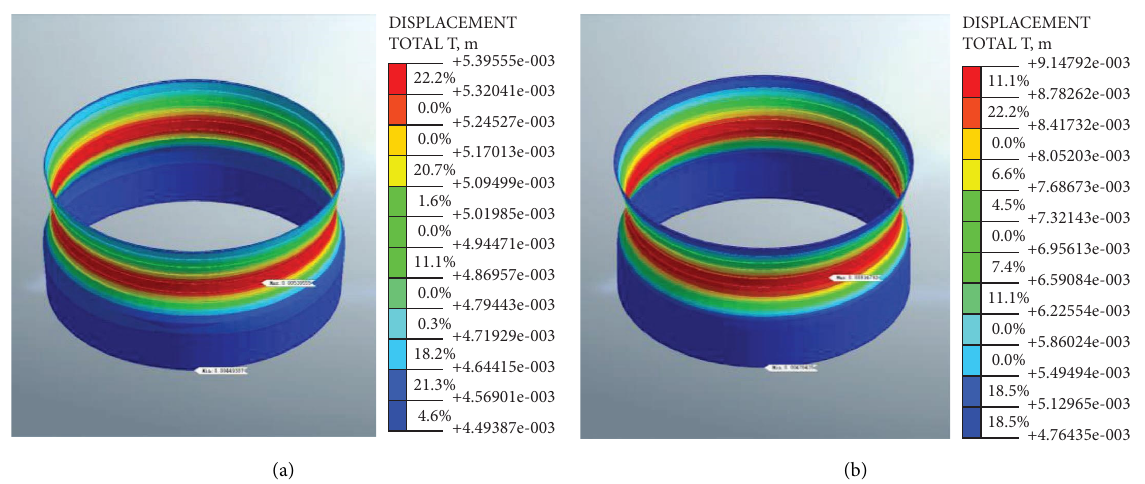
Figure 26: Working condition 8 wall deformation (a) without pore water pressure and (b) with pore water pressure applied.